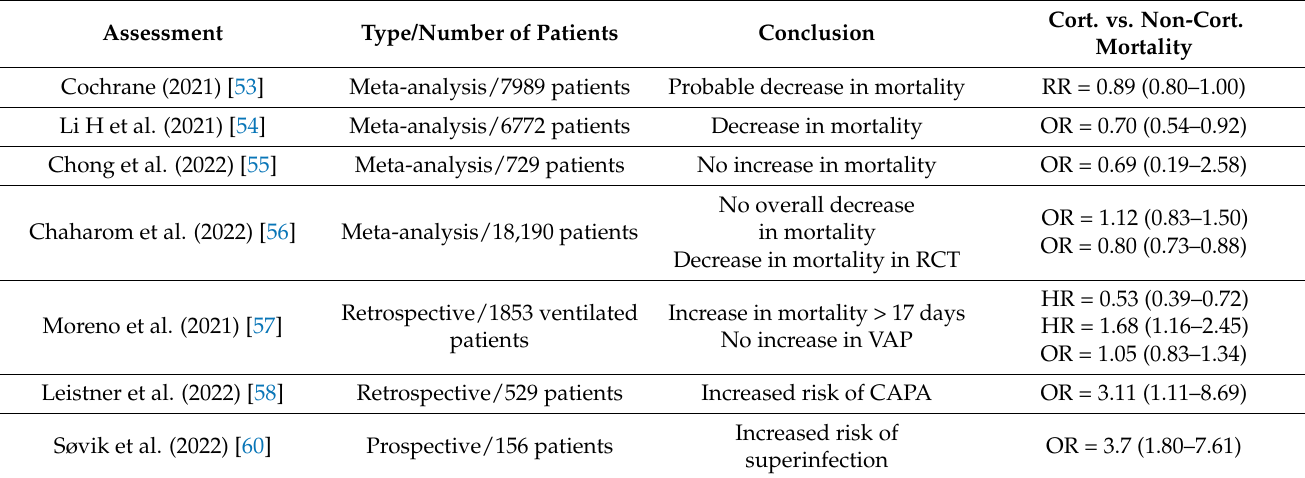
Table 5. Studies Assessing the Administration of Corticosteroids in Patients with